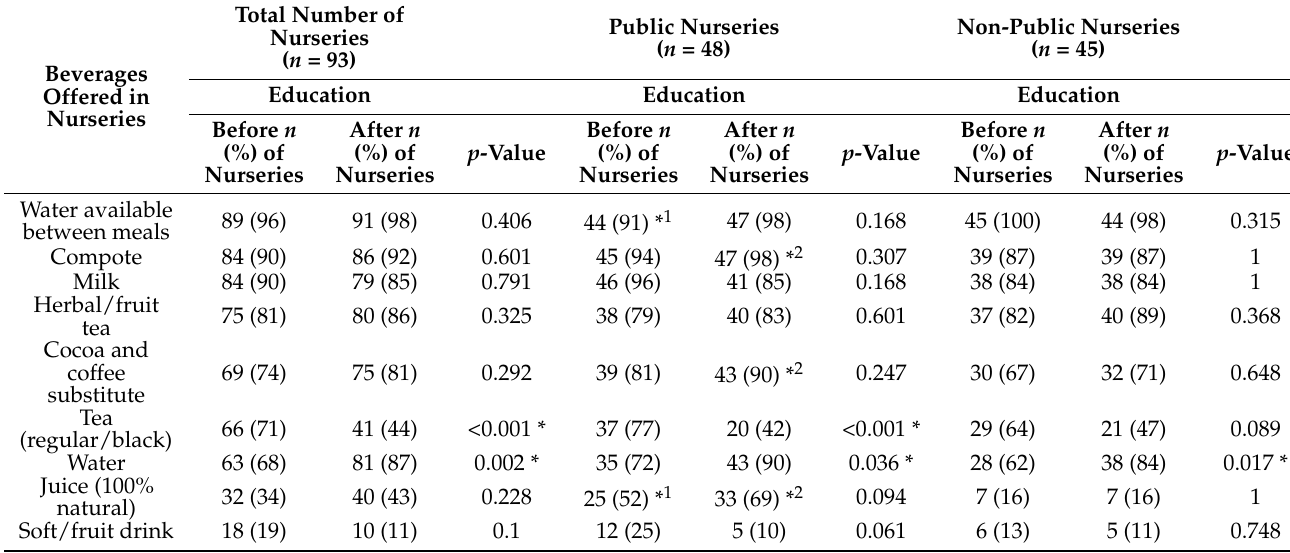
Table 2. Assortment of beverages offered to children in nurseries before and after nutritional education for the total group as well as considering the type of